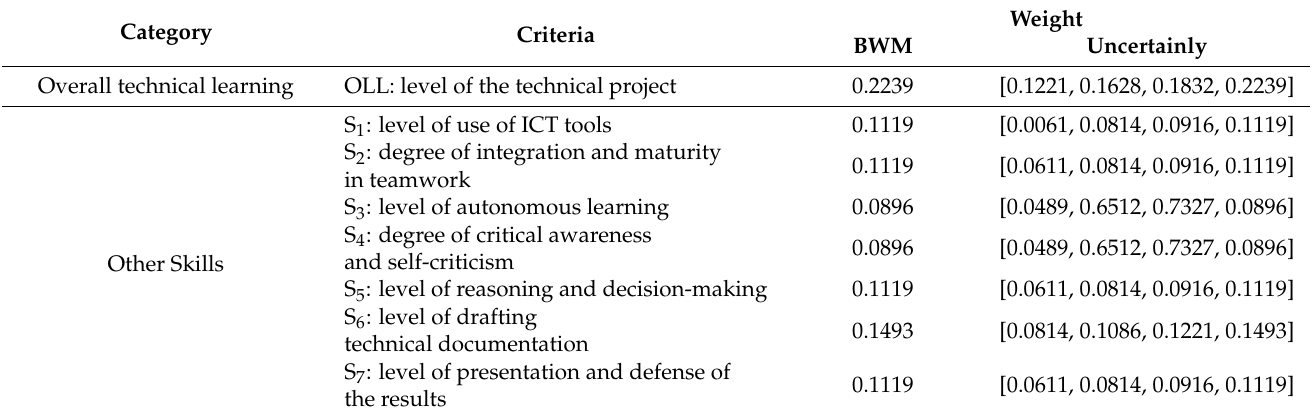
Figure 2. Evaluation phases. Table 4. Criteria used to academic evaluation: criteria and relative importance of each crite- rion